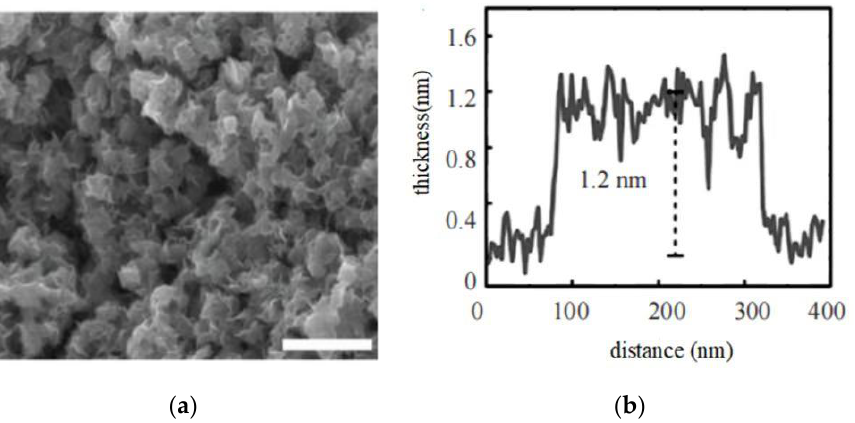
Figure 3. Two-dimensional nanometer black card, microscopic-size image. ( a ) Electron microscope scanning image; ( b ) corresponding height-distribution image.